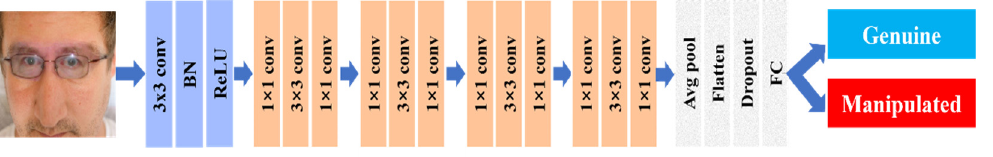
Figure 4. Architecture of the face manipulation identification model (motivated by the RegNet structure). Note: BN stands for batch normalization; conv is a convolutional layer; avg pool is the average pooling; FC indicates a fully connected layer.